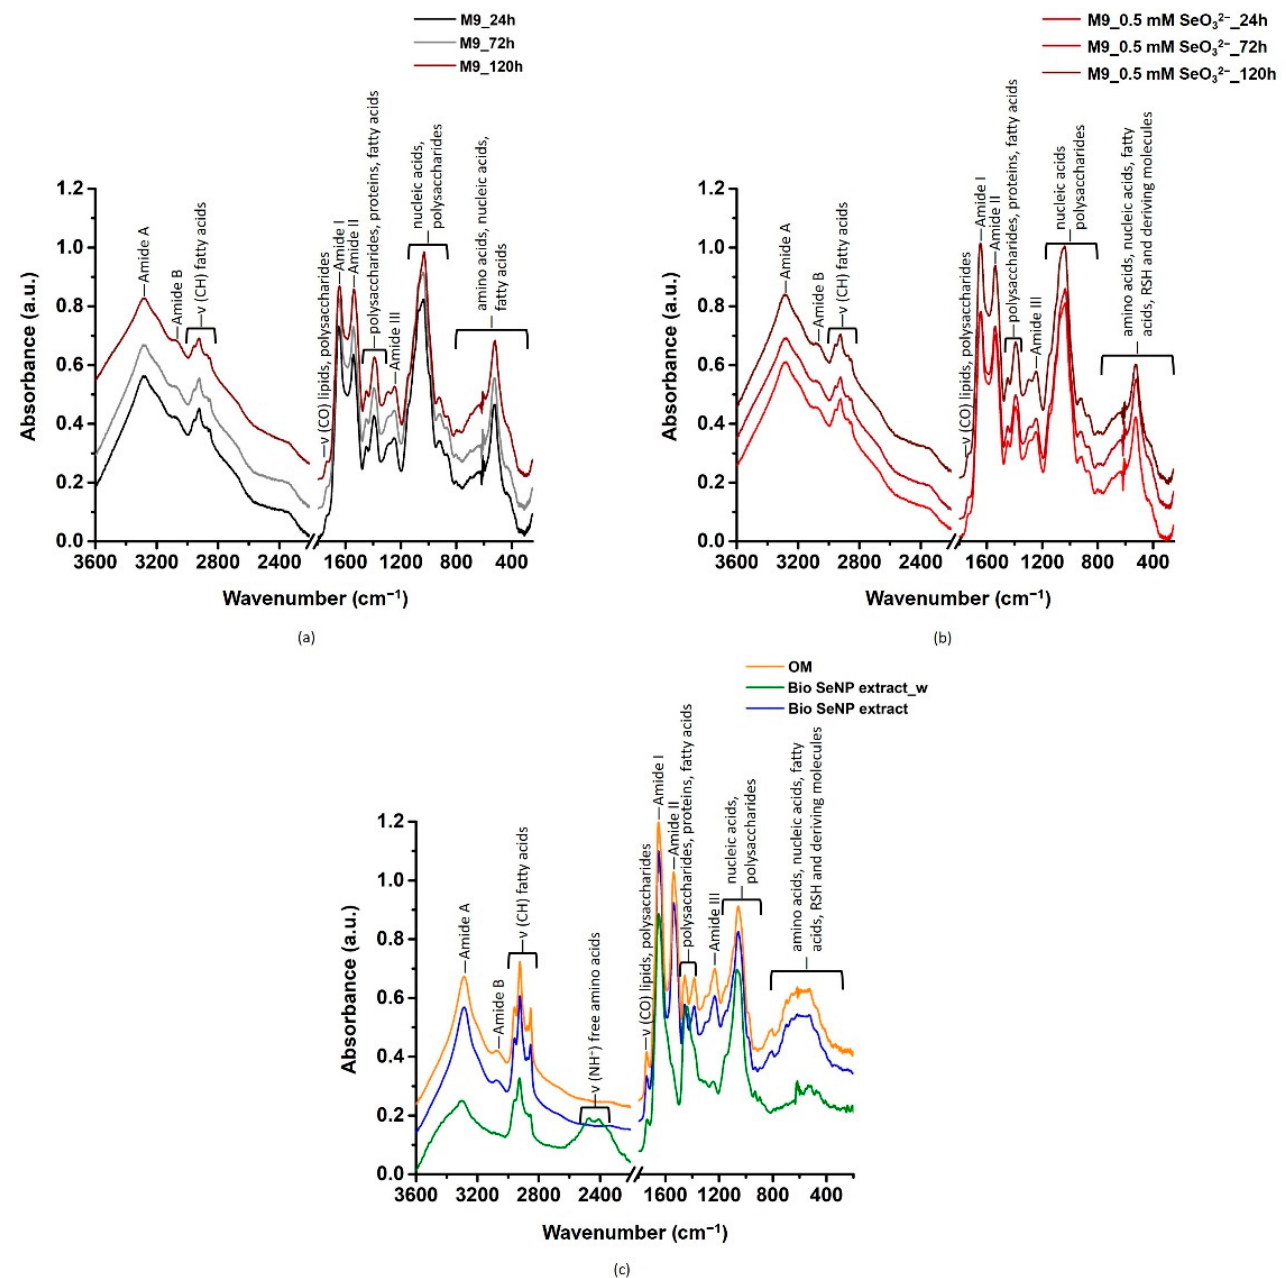
Figure 3. ATR-FTIR spectra of Micrococcus sp. cells exposed for 24, 72, and 120 h to ( a ) glucose or ( b ) glucose and SeO 3 2 − , and ( c ) the recovered biogenic extracts and OM. For clarity, the spectra were offset of 0.1 a.u.